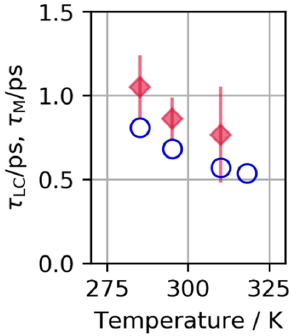
Figure 8. Temperature dependence of the Maxwell relaxation time (circle) and τ LC determined from the Van Hove function (diamond) for water, in pico-second [37].